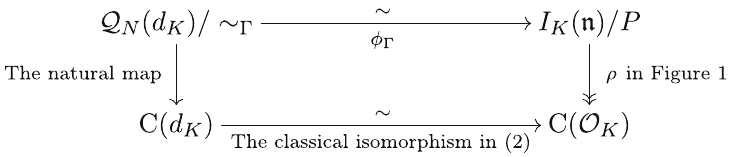
Figure 2: The natural map between form class